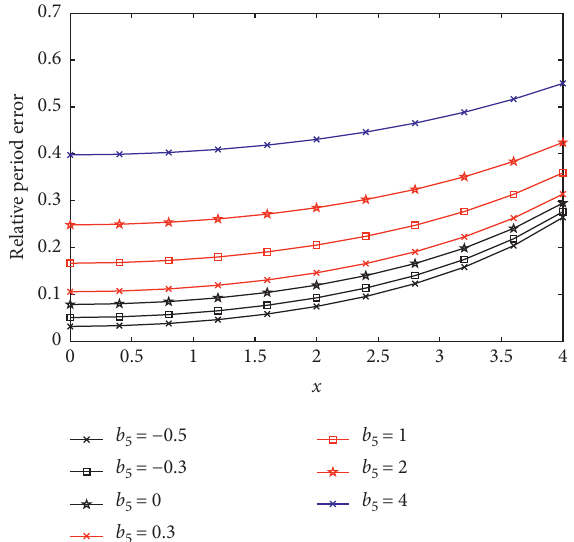
Figure 2: Variations in the relative period error of the preliminary and x when Δ t / T � 0 . 1 CQ-2 x method with b 5